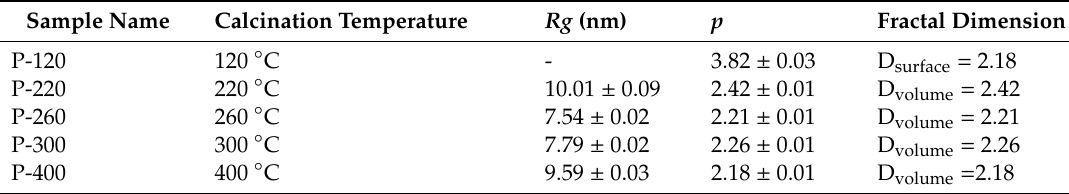
Figure 6. Measured and modelled SANS intensities versus scattering vector of hybrid xerogels calcined at di ff erent temperatures. Table 3. Parameters from the SANS curves